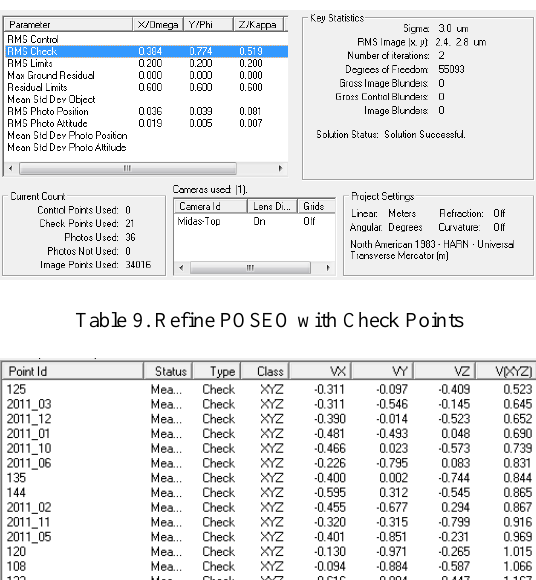
Table 8. Direct Geo Referencing (DGR) + Control